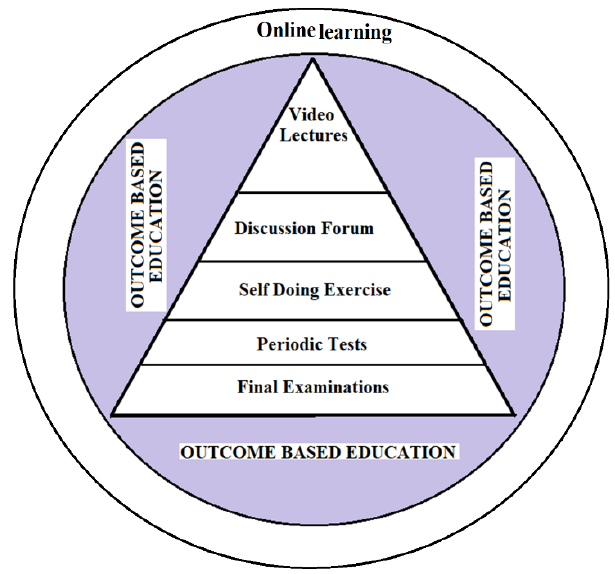
Figure 10. Online Learning Pyramid Architecture to achieve